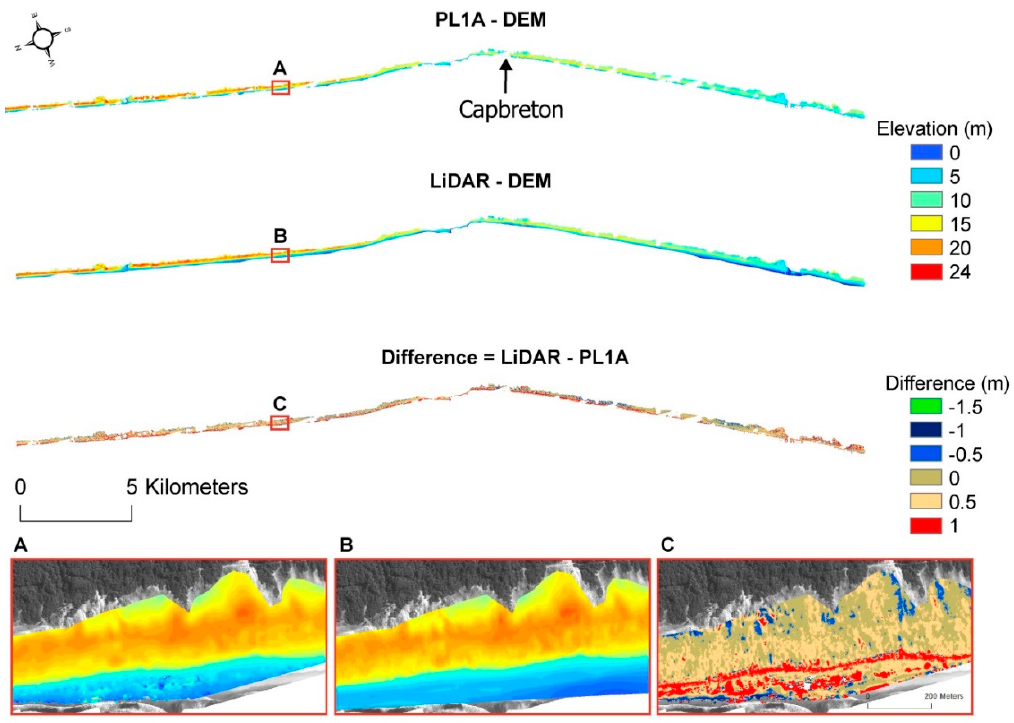
Figure 4. Results of the comparisons between the Pleiades (PL1A) and LiDAR DEMs. The lower panel presents three subsections of the study area showing the DEM produced with Pleiades ( A ), LiDAR ( B ) and the difference between the two ( C ). Note that the maps of the DEMs were rotated 110º in order to present them horizontally.